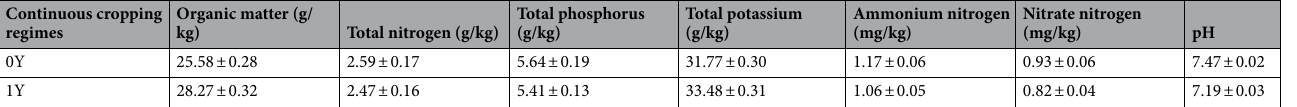
Table 1. Soil physicochemical properties. 0Y and 1Y represent 0 year and 1 year of continuous cropping,